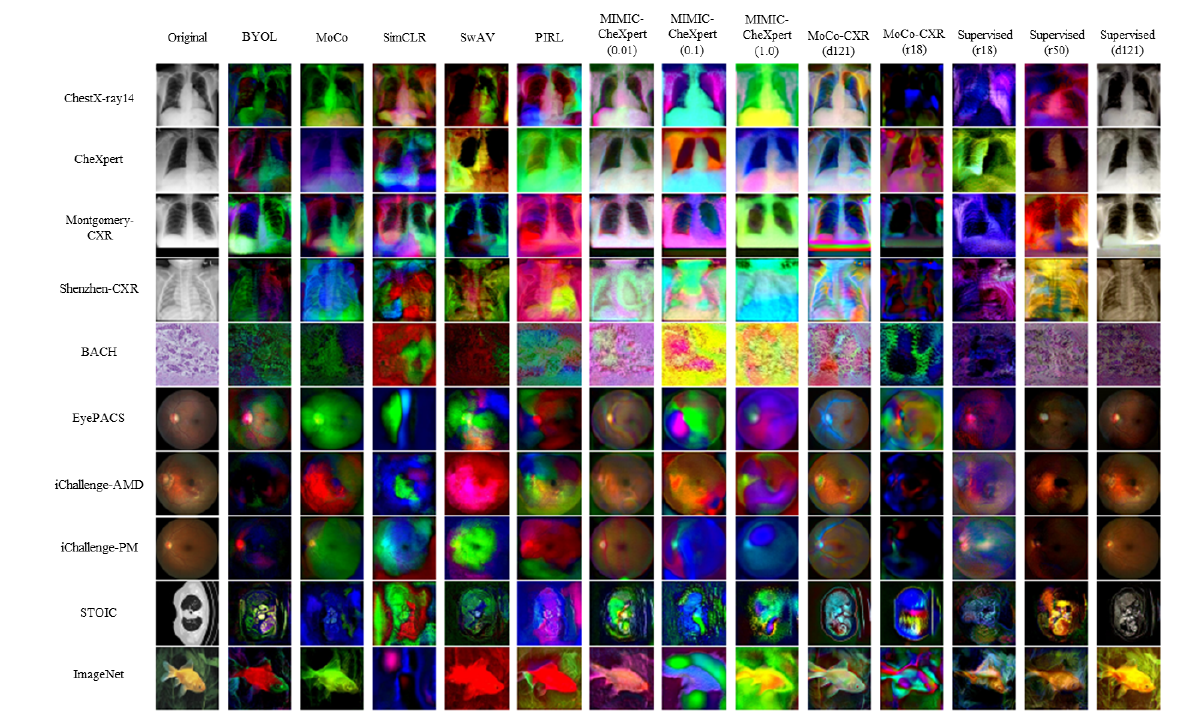
Figure A5. Deep image prior reconstructions for all models on one image from each dataset.